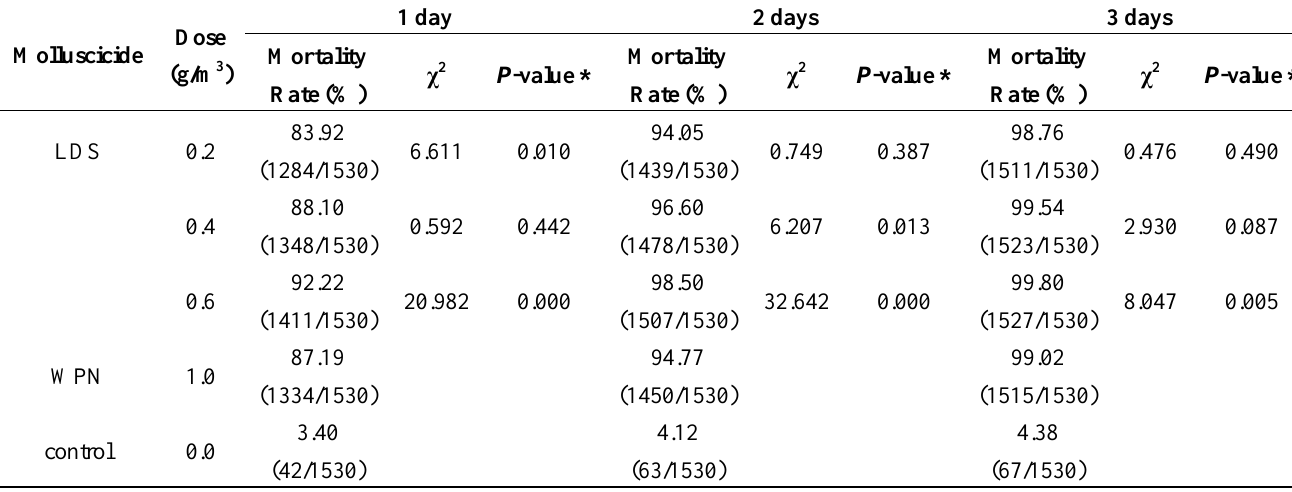
Table 1. Comparison of the adjusted mortality of snails exposed for 24–72 h to different concentrations of LDS and WPN applied by immersion in 15 counties of Hubei